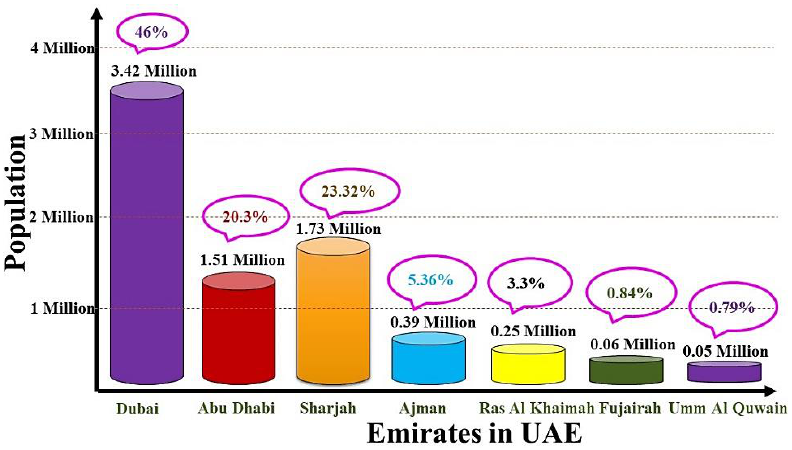
Figure 5. Population growth of the seven emirates of the UAE in 2021 based on the last known official population estimate and growth rate [51,52].